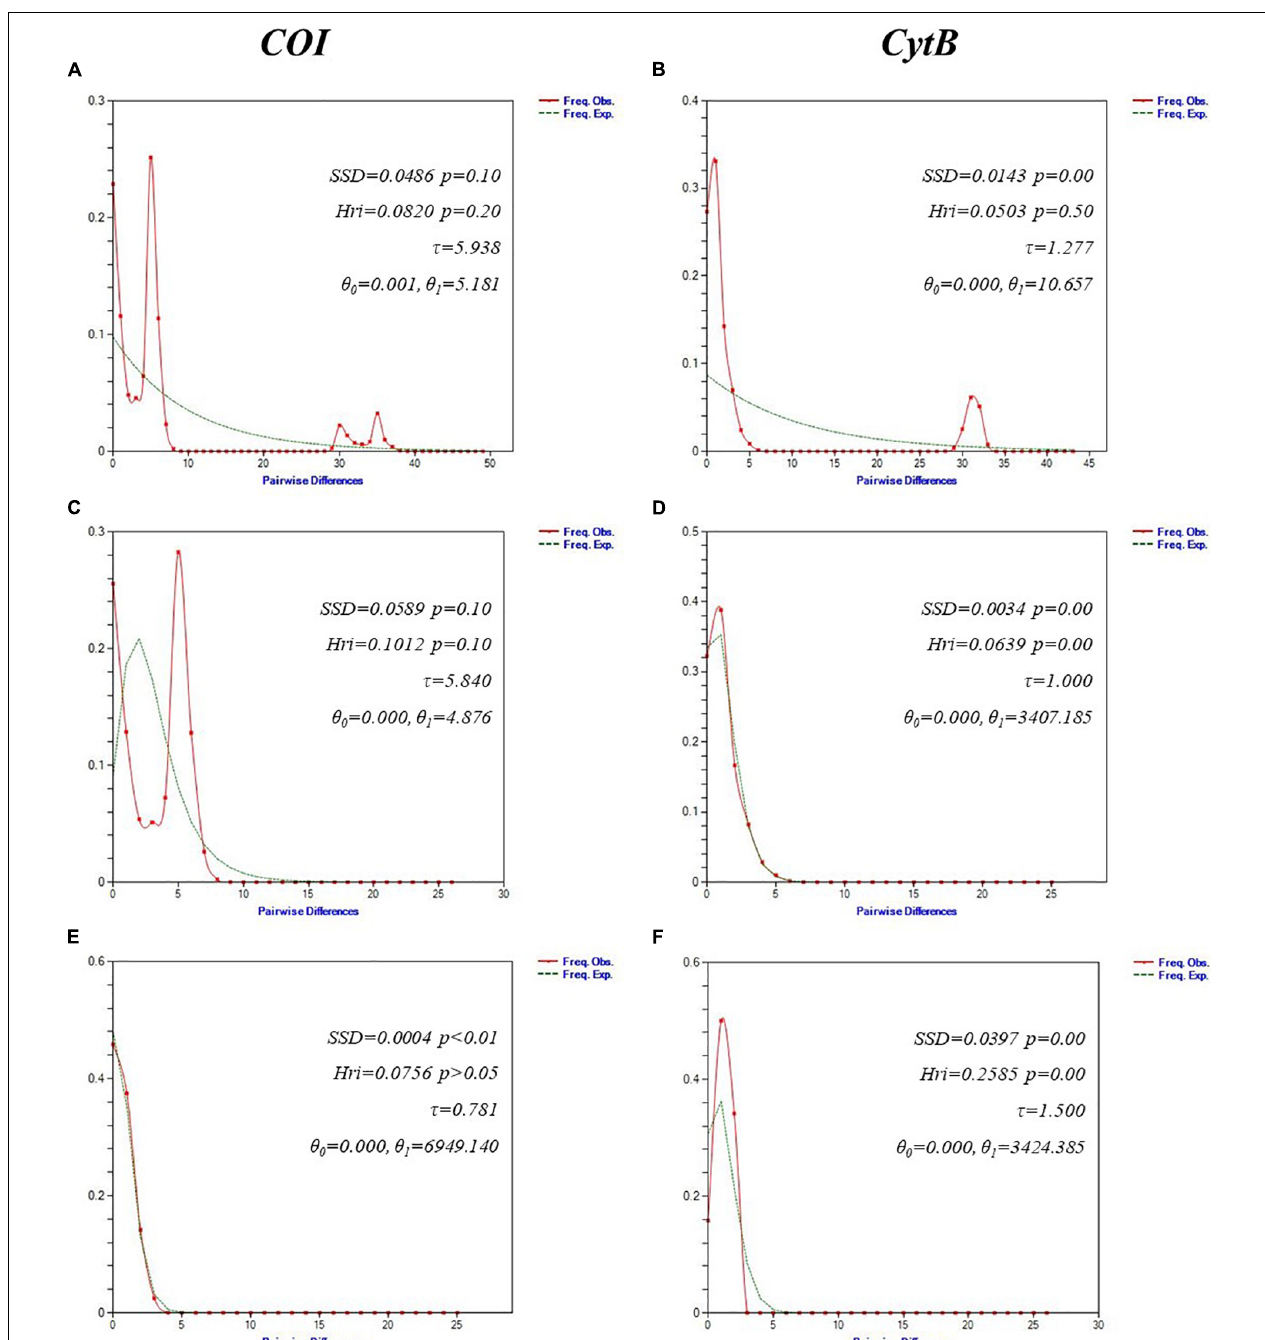
FIGURE 4 | Mismatch distribution analysis for S. leptolepis mtDNA cytochrome oxidase I (COI) (left) and cytochrome B (CytB) (right) using DnaSP v6.12. Graphs of the mismatch distributions of (A,B) overall populations; (C,D) Asian lineage; and (E,F) Australian lineage. The X -axis shows the observed distribution of pairwise nucleotide differences while Y -axis shows the frequencies. Solid lines represent the observed frequency of pairwise differences and broken lines show the expected values under the sudden expansion model. Sum of squared deviation (SSD) and Harpending’s raggedness index (Hri) indices with corresponding p -values are also